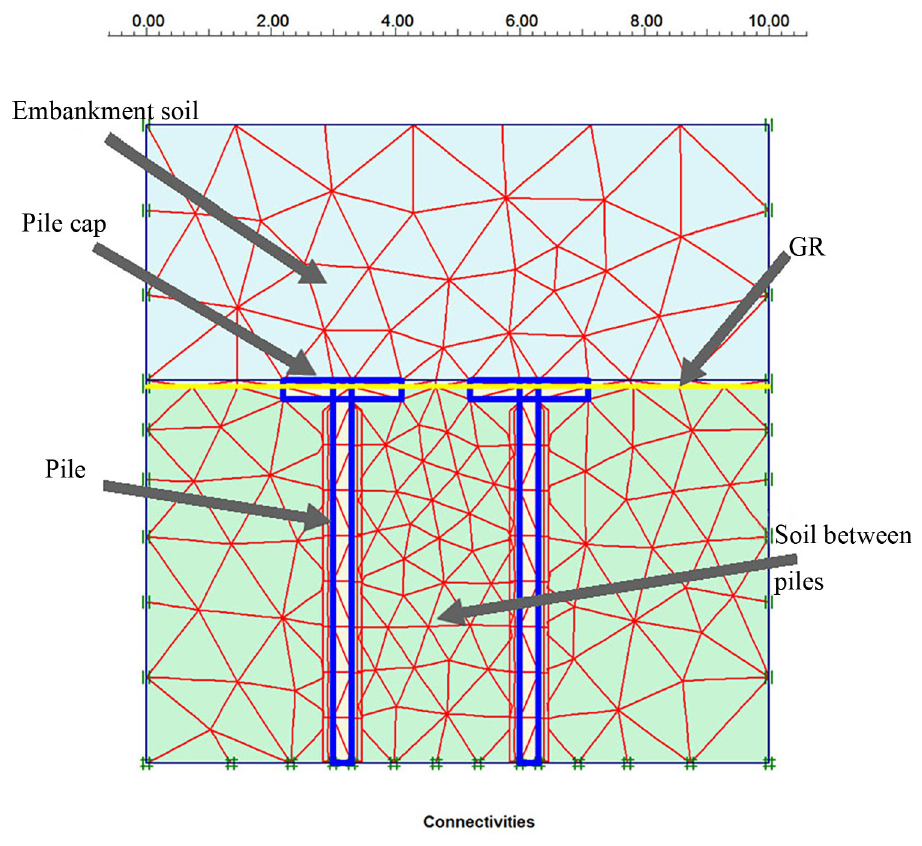
Fig 10. Finite element